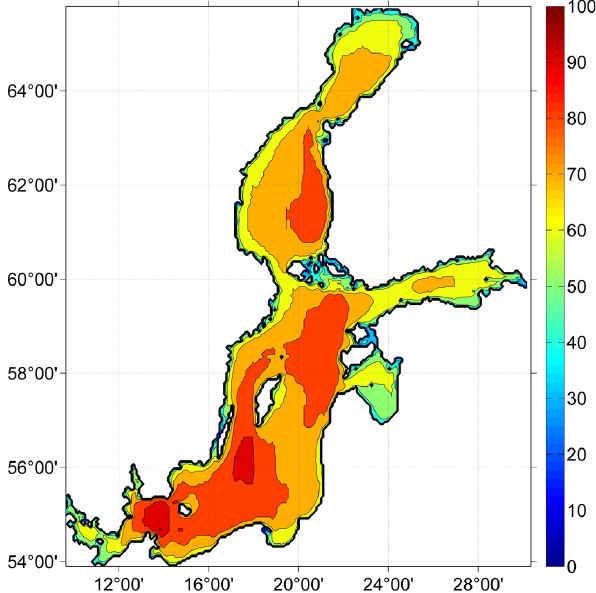
Fig. 2. Numerically simulated average significant wave height (colour bar, cm; isolines plotted after each 10cm) in the Baltic Sea in 1970–2007 (from R¨a¨amet and Soomere,